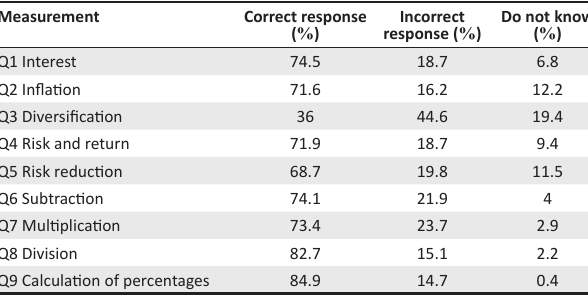
TABLE 3: Responses to financial literacy questions.